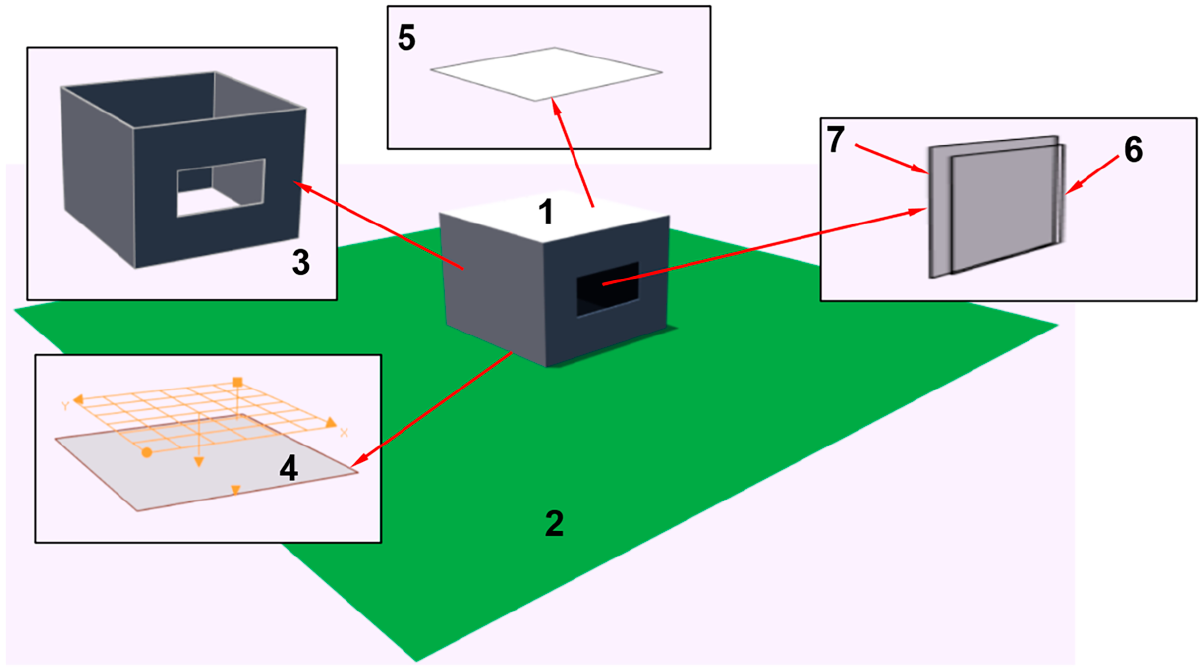
Figure 3. Scheme of the first verification scene.